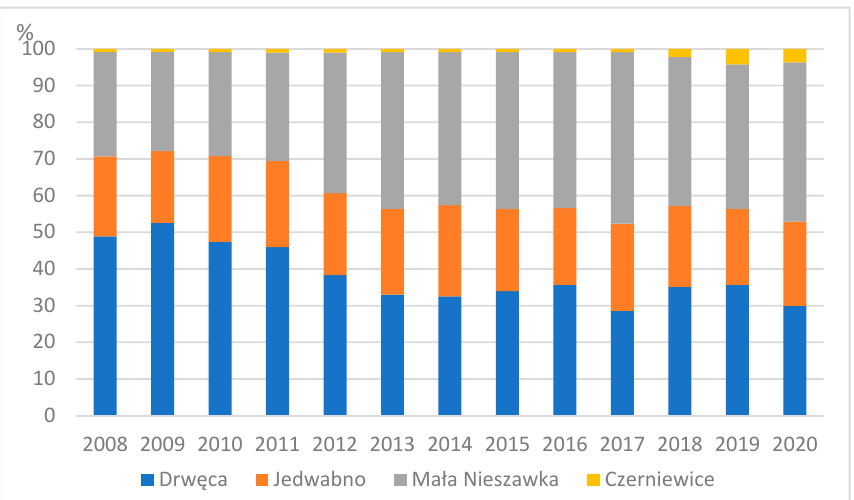
Figure 3. The contribution of water channeled into the water supply system from particular water intakes according to the total water balance.